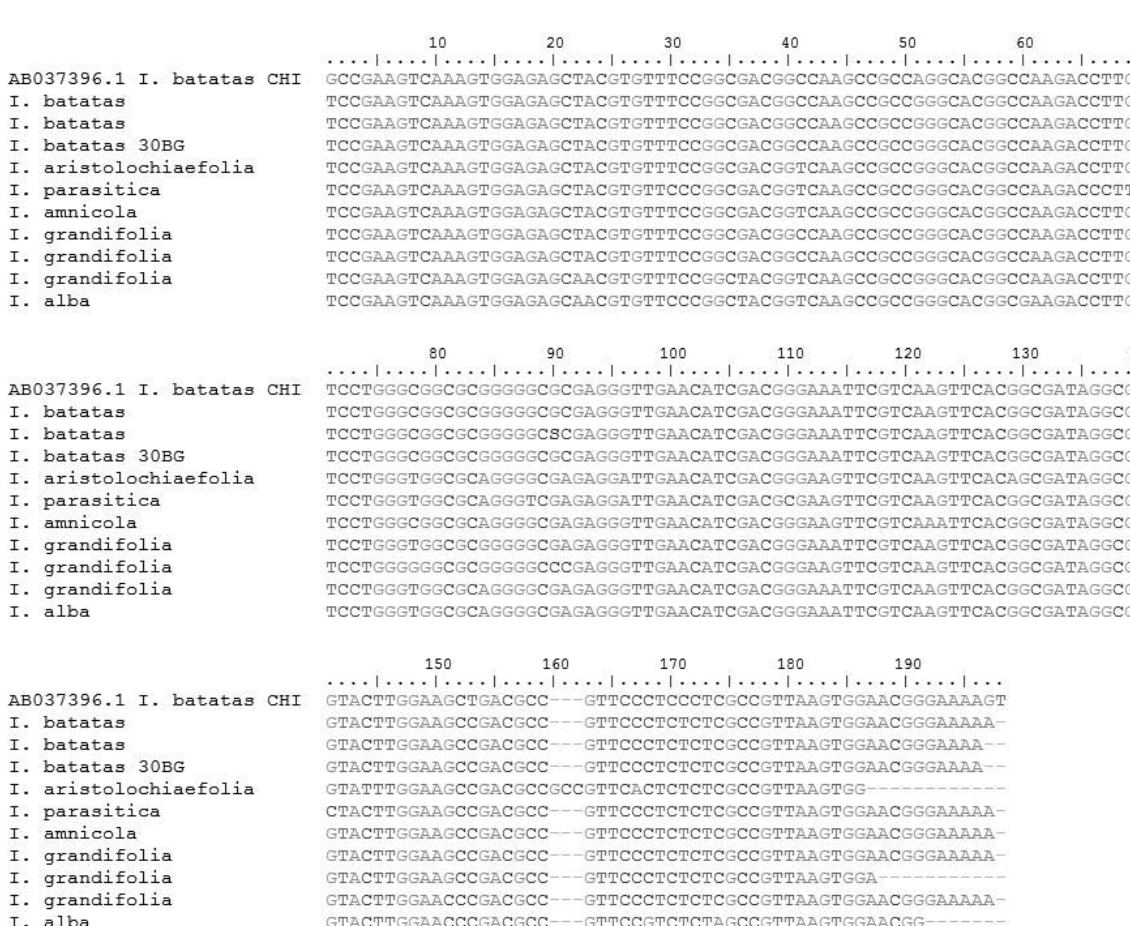
Figure 3. Sequence alignment of different genomic sequences amplifi ed with Ib-CHI-1 ( I. batatas and fi ve wild Ipomoea species) and mRNA of I. batatas (AB037396.1). The sequence corresponds to exon